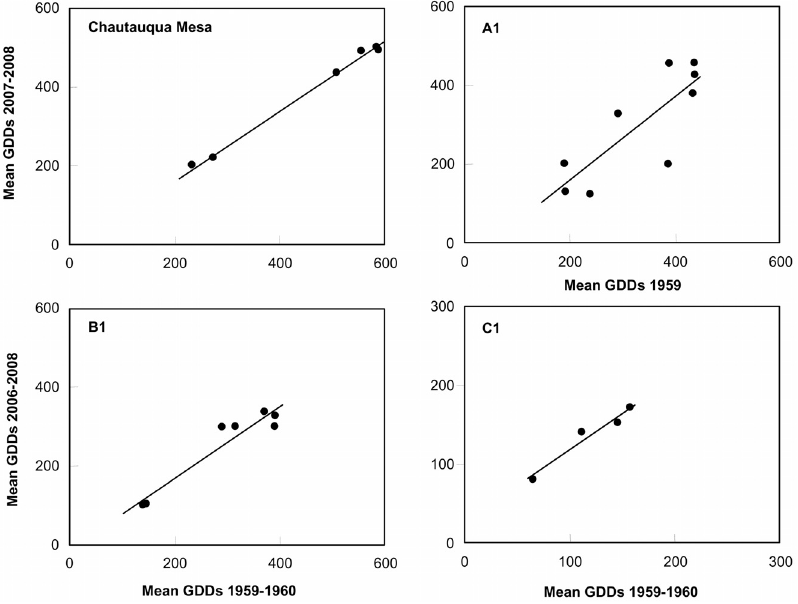
Figure 3. Thermal energy required by species to reach adulthood. Growing degree day (GDD) values associated with different grasshopper species at each of thefour survey sites duringAlexander’s original survey (1959–1960) andthe current resurvey (2006–2008). Note that original estimates of GDD values for A1 include data from1959 and that due to the much lower number of GDDs required by species at C1, the figure scales differ.